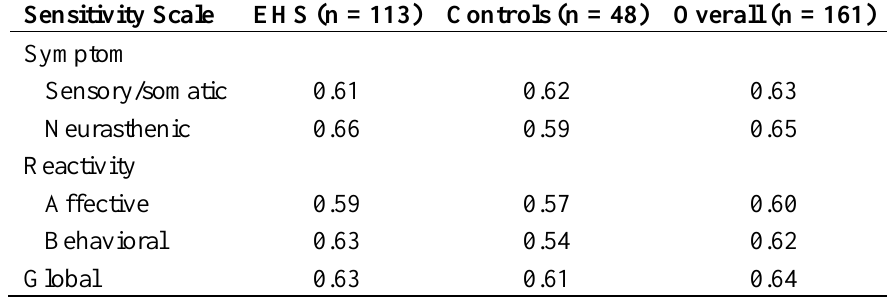
Table 4. Pearson correlation coefficients between scores on the subscales and global measure of the Chemical Sensitivity Scale and the Noise Sensitivity Scale for the group with electromagnetic hypersensitivity (EHS), the control group, and the overall